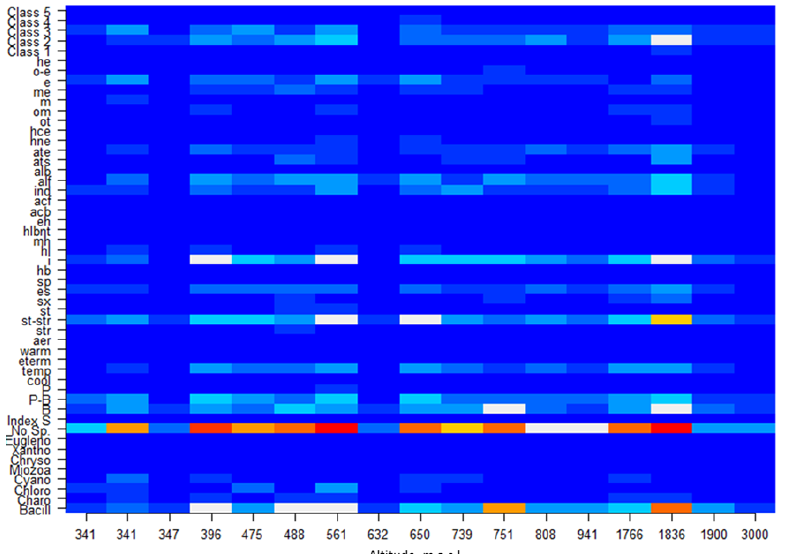
Figure 9. Heat map for species richness in phyla, index of organic pollution S, and species number in the groups of indicators in the communities over the studied sites at South and Southeast Kazakhstan, 2019–2022. Abbreviations in the y-axis and station numbers in the x-axis are the same as in Table 3. Sampling stations are in order of its altitude increasing. The color of the cells varies from white to blue then to red according to the proportion of the number in the entire